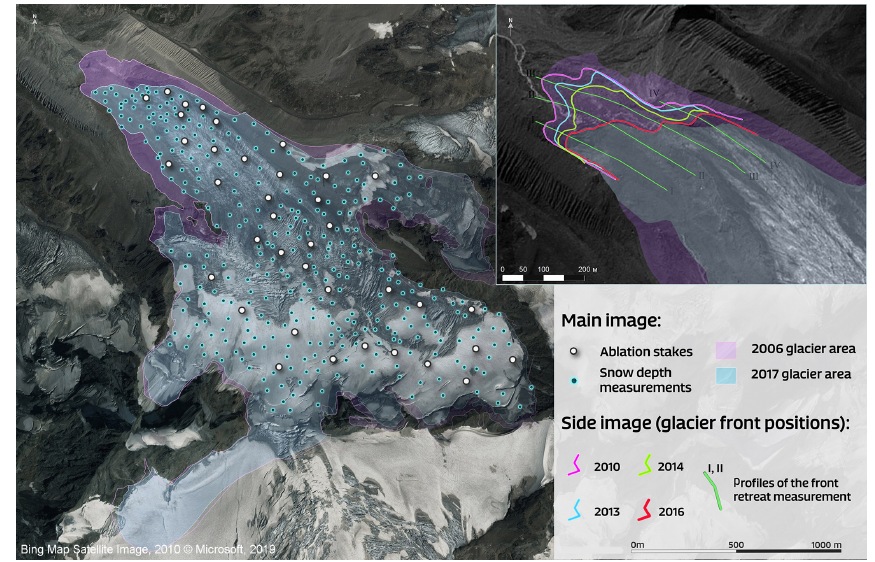
Figure 8. The spatial distribution of ablation stakes and snow thickness measurement points, change in the Djankuat glacier area during the study period, and glacier front